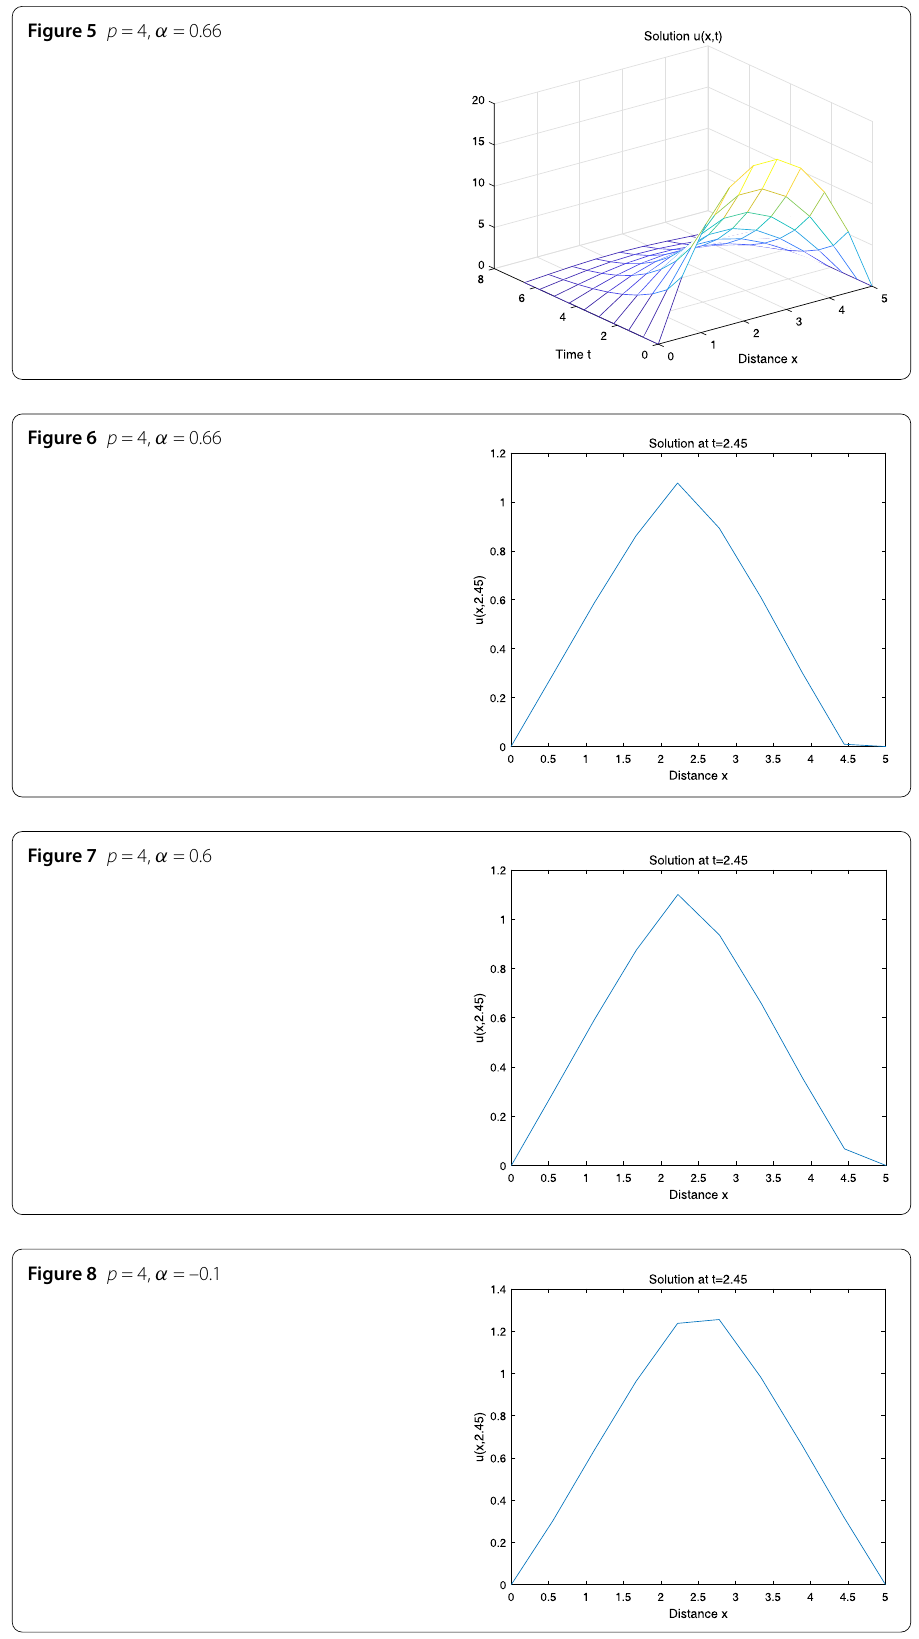
Figure 5 p = 4, α = 0.66